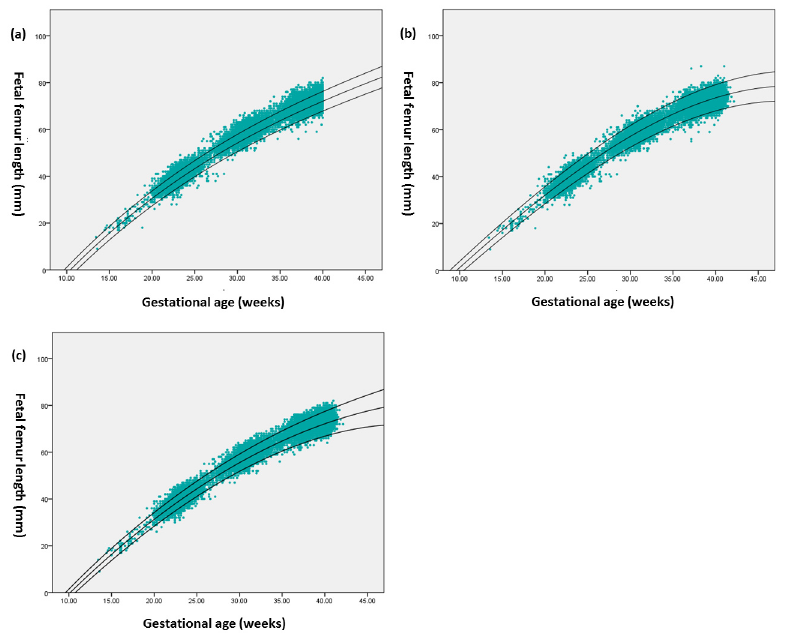
Fig 2. Scatter diagrams with the 5 th , 50 th , and 95 th percentile curves calculated from and superimposed on each reference chart of FL. The 5th (bottom line), 50th (middle line), and 95th (top line) centile curves for fetal femur length using each of the reference equations of Leung TN,et al (a), Chitty LS, et al (b),Papageorghiou, AT, et al (c), superimposed on the scatter diagram of FL and